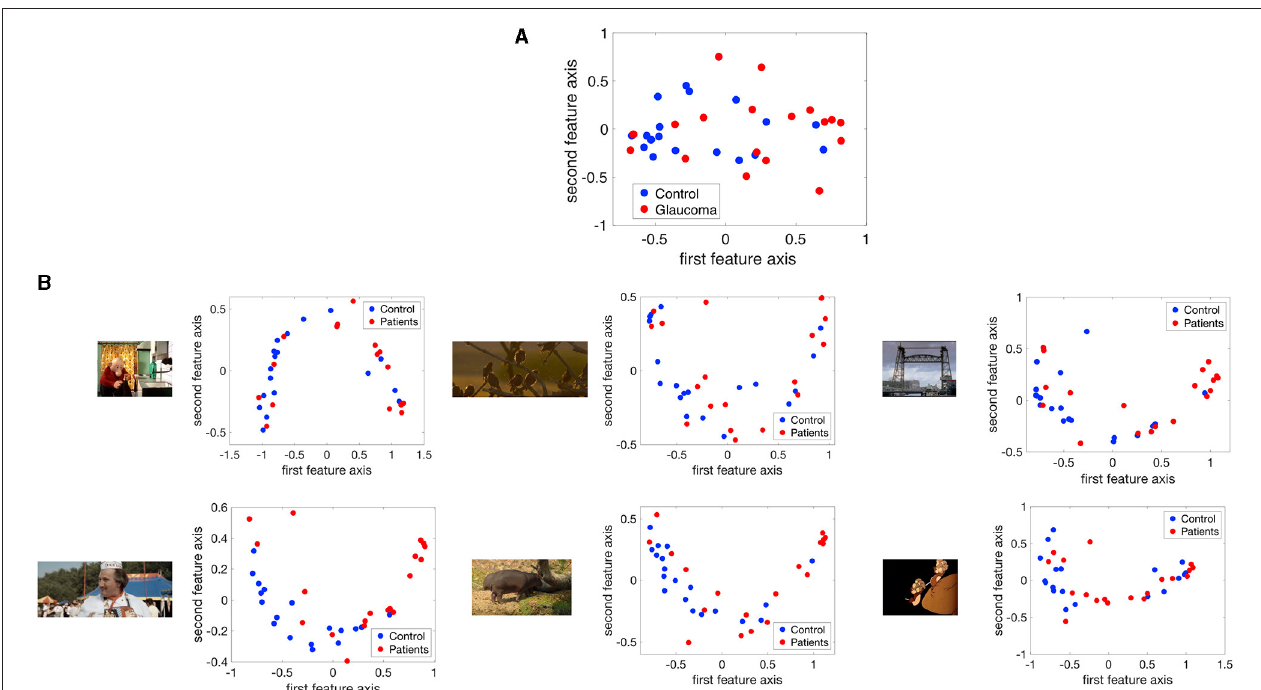
FIGURE 5 | The fixation maps of each participant projected onto the two axes of the high dimensional kernel space with the highest covariance. We used (A) the mean and the maximum Euclidean distance between all fixation maps of each participant for the kernel and (B) the distance between fixation maps of individual video clips. These are representative